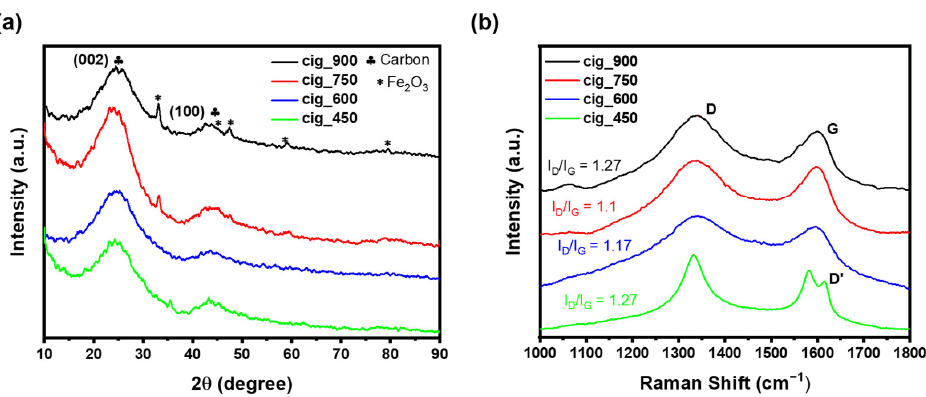
Figure 2. ( a ) XRD spectra and ( b ) Raman spectra of the as-prepared samples.